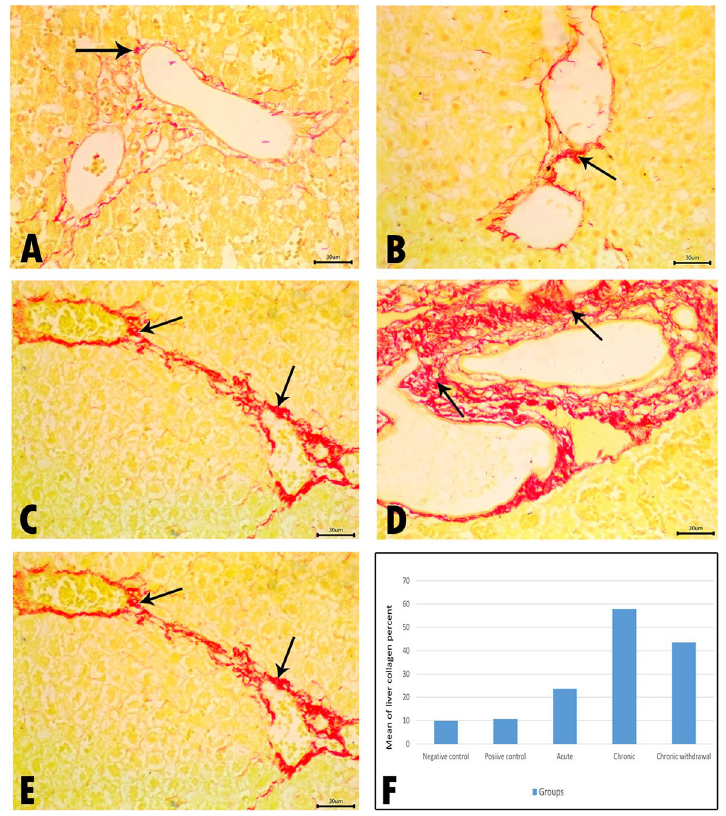
Fig. 8 Photomicrographs of sections in the liver stained with SR ( around portal tract (arrow). C , D , and E : Acute, chronic, and chronic withdrawal groups reveal increased in collagen fibers around portal tract (arrows) compared to the control groups. F : showing the mean area % of collagen fibers in all groups. Data are expressed as mean for control groups vs acute, chronic, chronic withdrawal